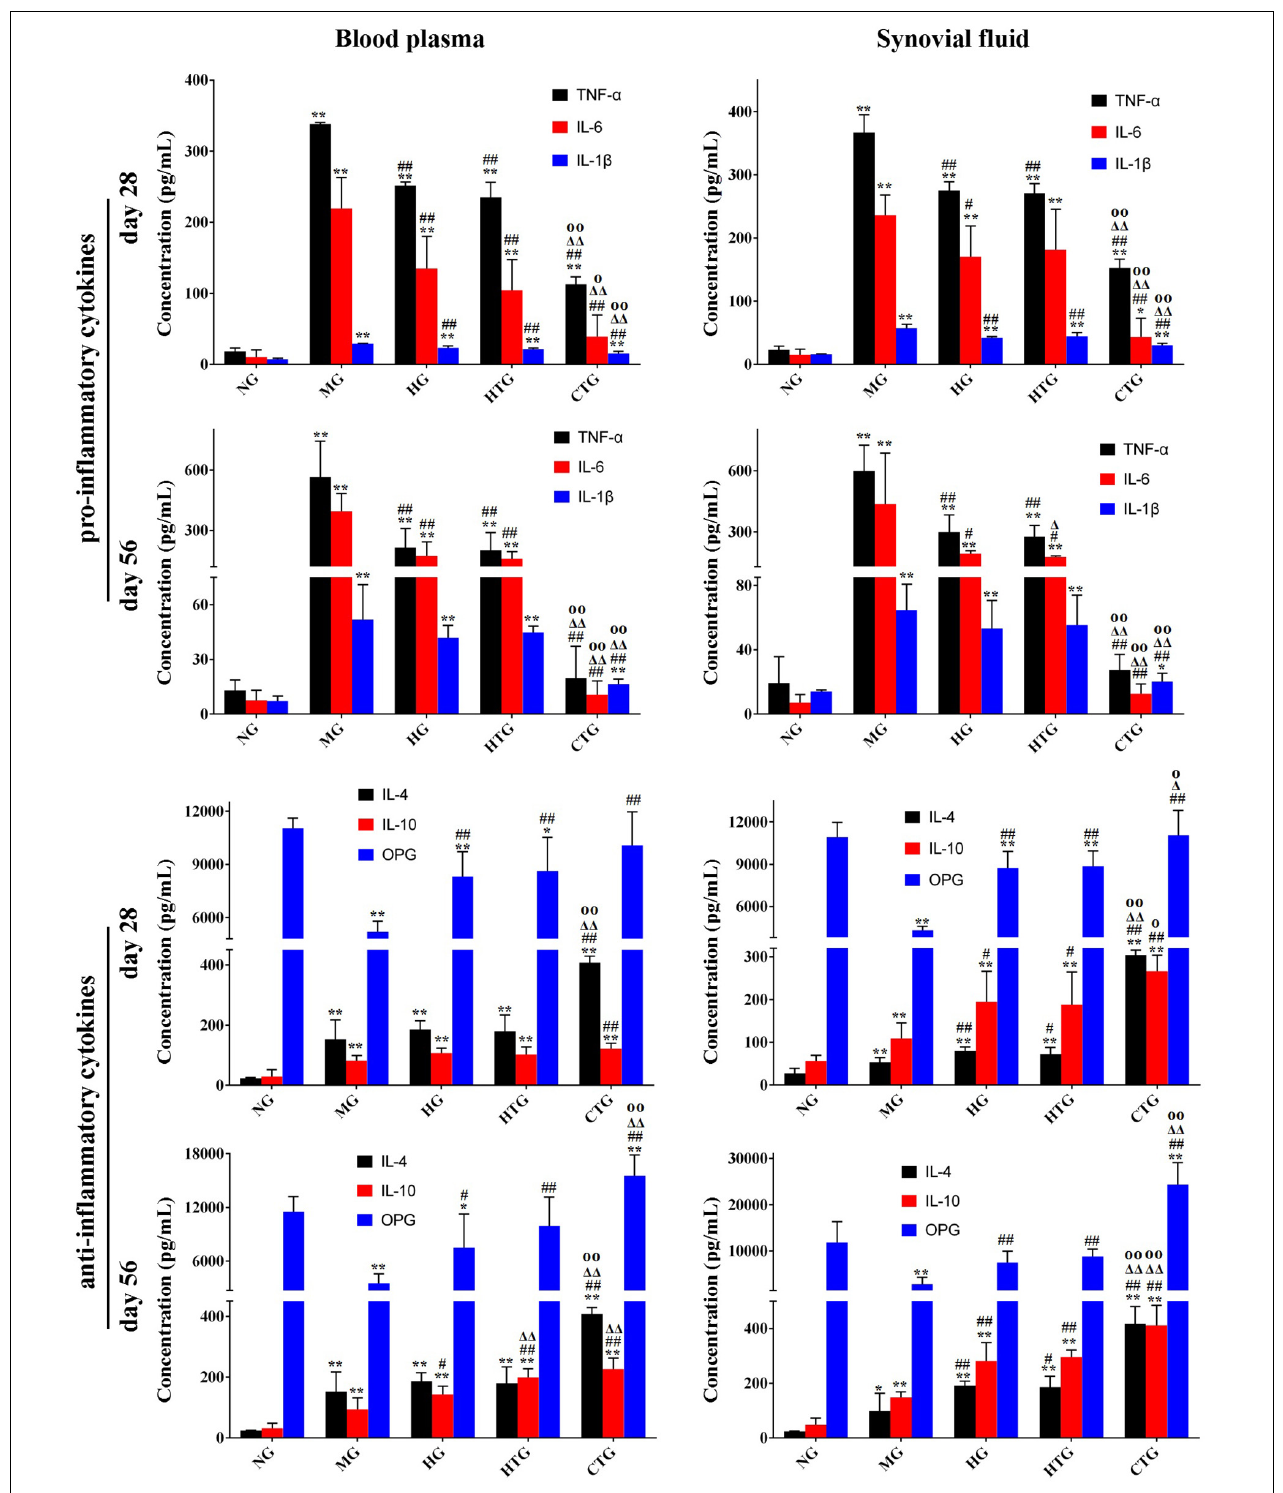
FIGURE 7 | Expression of cytokines in blood plasma and synovial fluid in rat OA models. NG, LG-DMEM; MG, Model group; HG, 0.05 mg/mL HA; HTG, hAMSCs 1 × 10 6 ; CTG, HA (0.05 mg/mL) + hAMSCs (1 × 10 6 ). The data are expressed as mean ± sd ( n = 6), * P < 0.05, ** P < 0.01 vs. NG; # P < 0.05, ## P < 0.01 vs. MG; (cid:49) P < 0.05, (cid:49) (cid:49) P < 0.01 vs. HG; O P < 0.05, OO P < 0.01 vs. HTG.